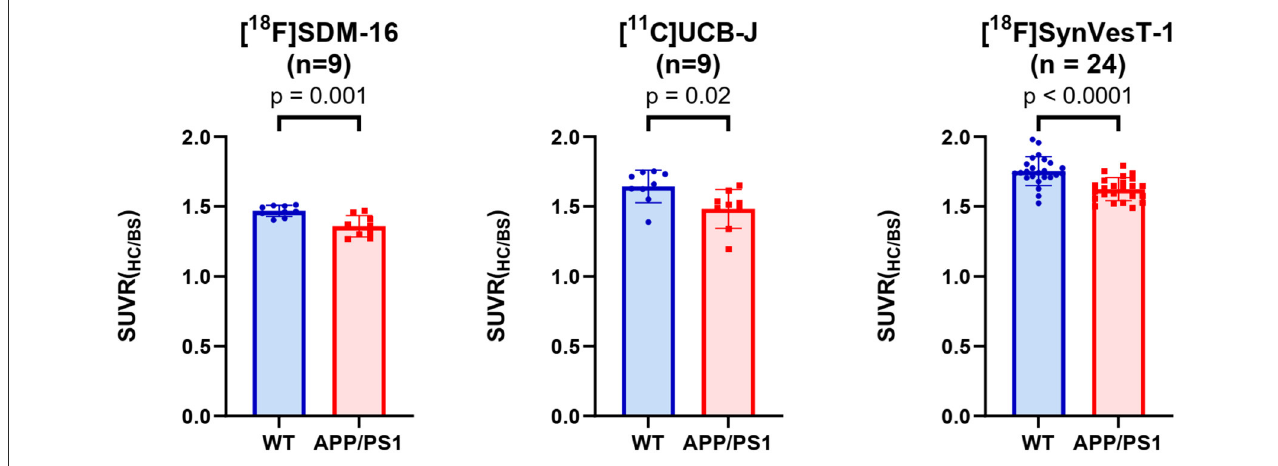
FIGURE5 Group comparisons of hippocampal SUVRs in APP/PS1 mice and WT mice, using [ 18 F]SDM-16, [ 11 C]UCB-J, and [ 18 F]SynVesT-1 and the corresponding optimal imaging windows, i.e., 60–90, 30–60, and 30–60min, for [ 18 F]SDM-16, [ 11 C]UCB-J and [ 18 F]SynVesT-1, respectively.